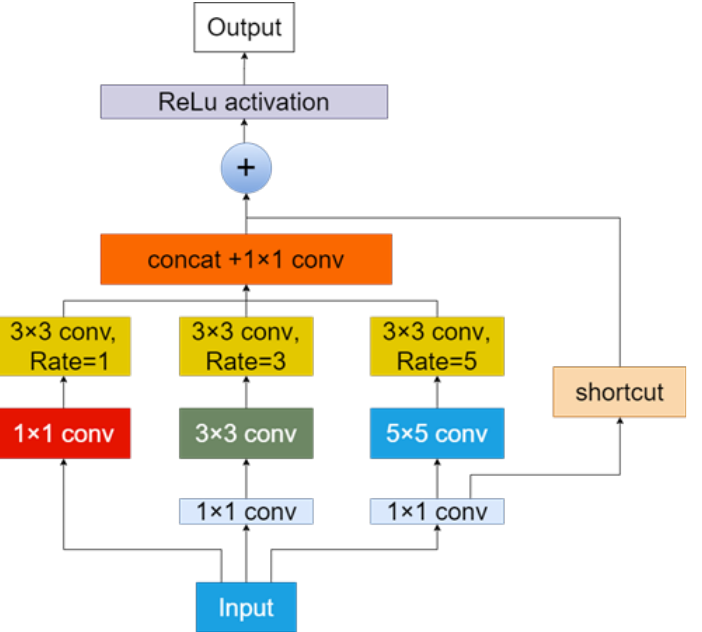
Figure 5. The structure of RFB.